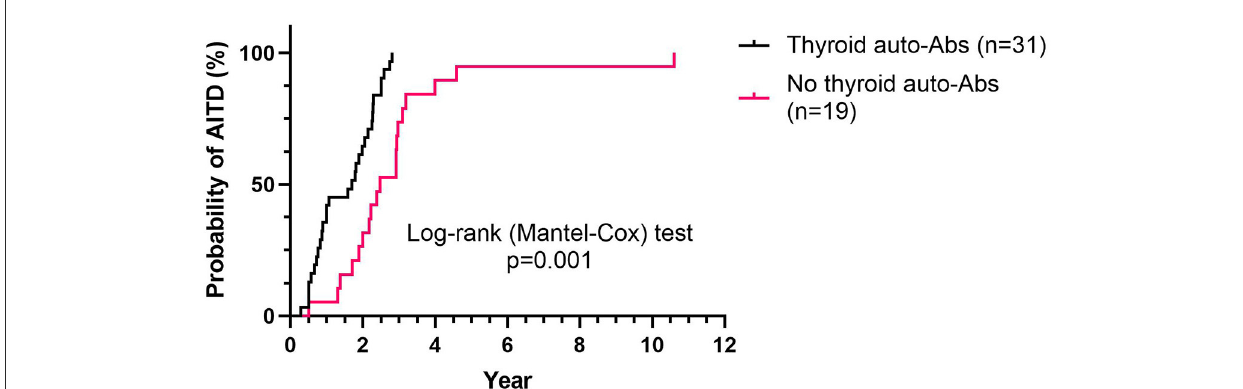
FIGURE1 Time to AITD diagnosis, relative to thyroid auto-Abs status. Kaplan–Meier plot shows the probability of developing AITD at the indicated time (years), according to the presence ( n = 31) or absence ( n = 19) of thyroid auto-Abs, among patients that developed an AITD during follow-up ( n = 50). AITD, autoimmune thyroid disorder; auto-Abs, autoimmune